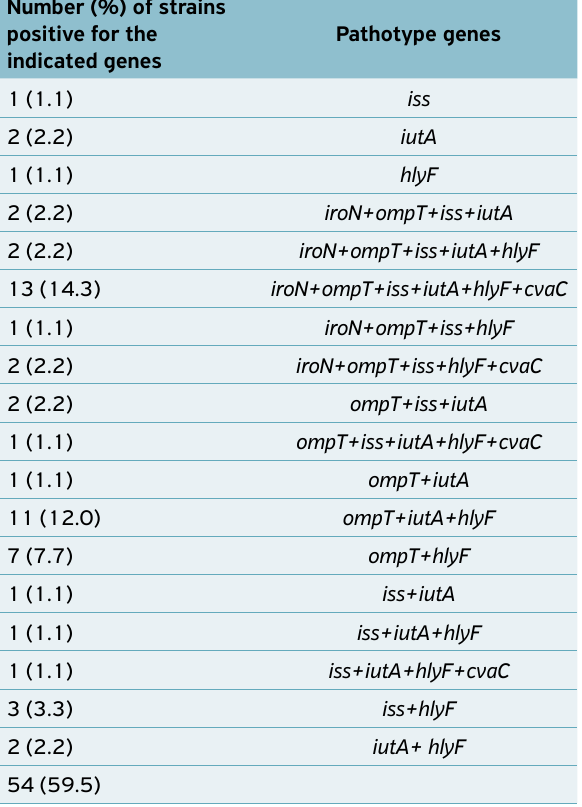
Table 1. Genetic profiles of E. coli strains isolated from poultry feces. Number (%) of strains